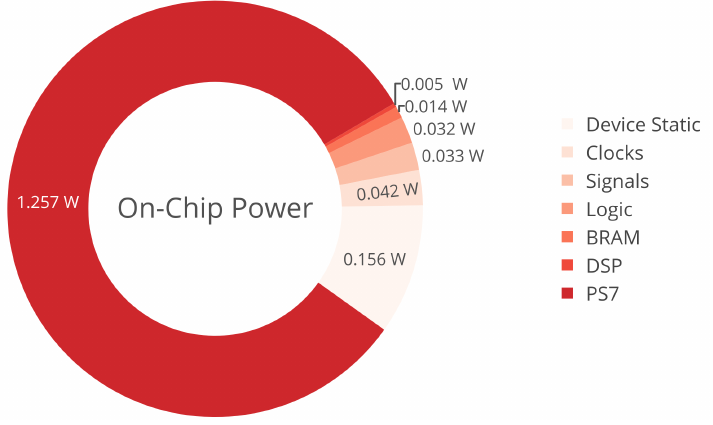
Figure 6. On-chip power